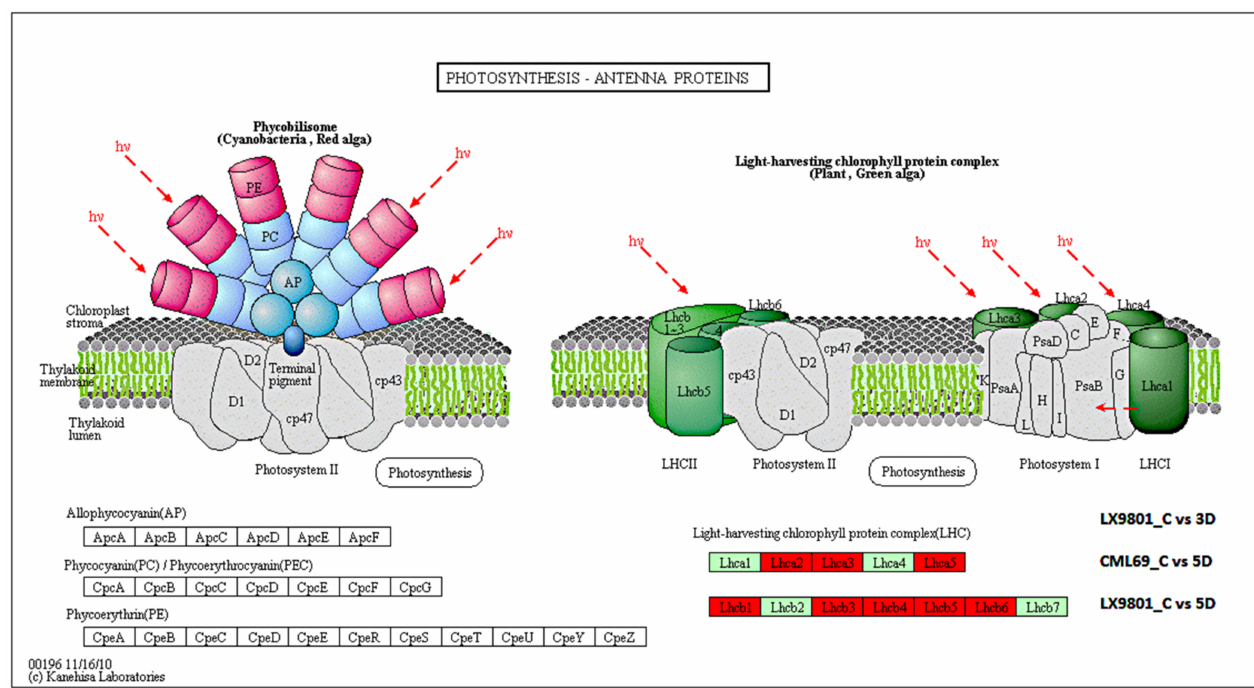
Figure 5. KEGG map of the photosynthetic antenna proteins. It is an analysis of DEGs, comparing drought-treated and control samples in both CML69 and LX9801. Boxes in a red frame indicate that the corresponding DEGs were downregulated in the drought-treated samples, and the boxes with a green frame suggest that the expression levels of the related genes were not changed as determined by our RNA-seq. Drought treatments are labeled as control (C), three days (3D), and five days (5D), and all genes’ abbreviations are defined in Table